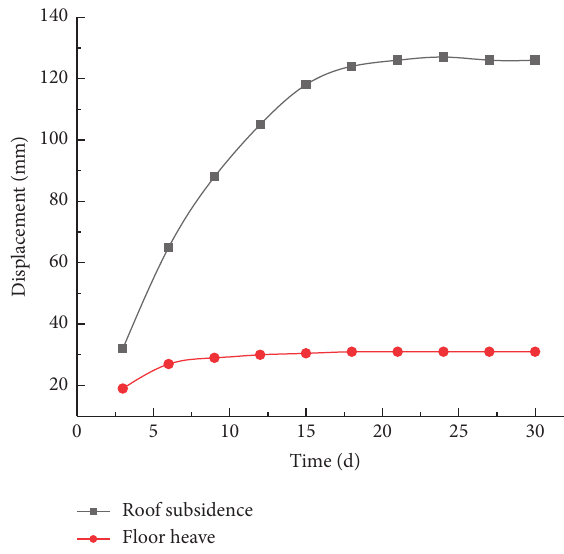
Figure 17: Amount of roof sinking and floor